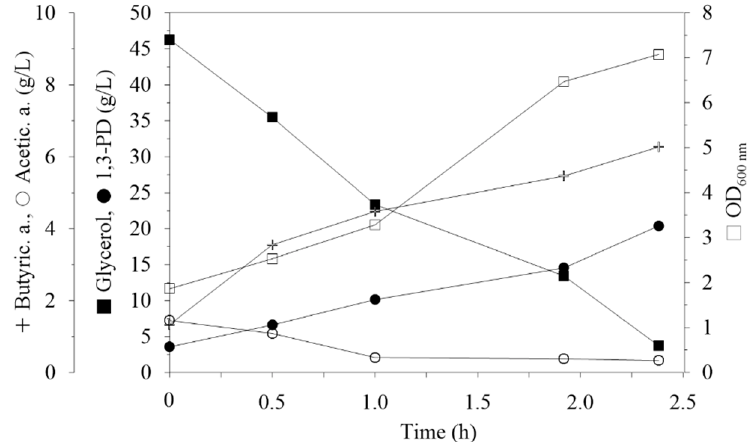
Figure 2. Fermentation profiles for the 26th repeated batch, run with the immobilized cells, at an initial concentration of pure glycerol 45.5 ± 0.7 g/L.